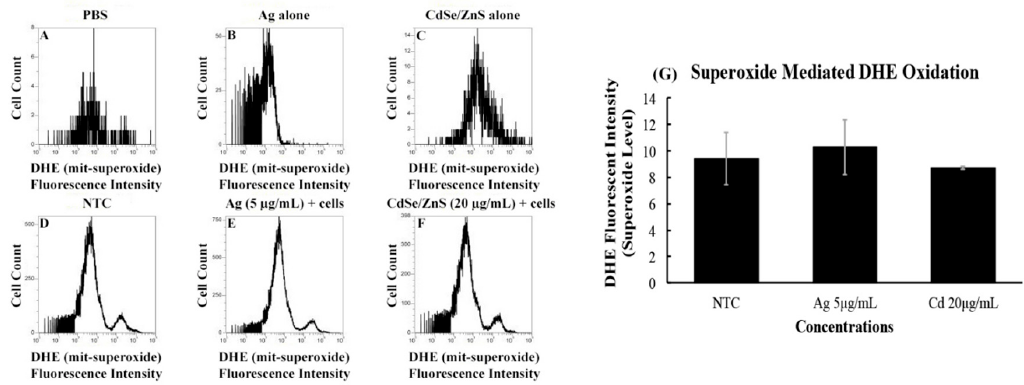
Figure 4. Quantitation of the levels of superoxide produced by cells treated with AgNPs or CdSe / ZnS-QDs. The cells were cultured for six hours with the nanomaterials, then cultured for 2 h with DHE (dihydroethidium) prior to the measurement of the amount of oxidized DHE, which indicates the levels of superoxide produced. ( A ) Non-treated cell control with only PBS and DHE; minimal background noise was detected. ( B ) Non-treated cell control with only AgNPs and DHE in PBS; a slight increase in background noise compared to PBS and DHE alone. ( C ) Non-treated cell control with only CdSe / ZnS and DHE in PBS (the highest background shows a fluorescent intensity detected at 10 3 ). ( D ) Non-treated control with cells with DHE in PBS. The major peak indicates the number of cells carrying non-oxidized DHE, while the small peak at fluorescent intensity 10 4.5 represents the number of cells carrying DHE oxidized by the superoxide produced. ( E ) The e ff ects of AgNPs (5 µ g / mL) on the production of superoxide, utilizing a similar method to Figure 4D. ( F ) The e ff ects of CdSe / ZnS (20 µ g / mL) on the production of superoxide in cells is indicated by the second peak, as explained in Figure 4. ( G ) Comparison of the percentage of cells that carry oxidized DHE in the non-treated control, AgNPs (5 µ g / mL)-treated cells, and CdSe / ZnS (20 µ g / mL)-treated cells. Each bar in the graph represents the average of three data sets, and this graph is one representation of three repeated experiments.